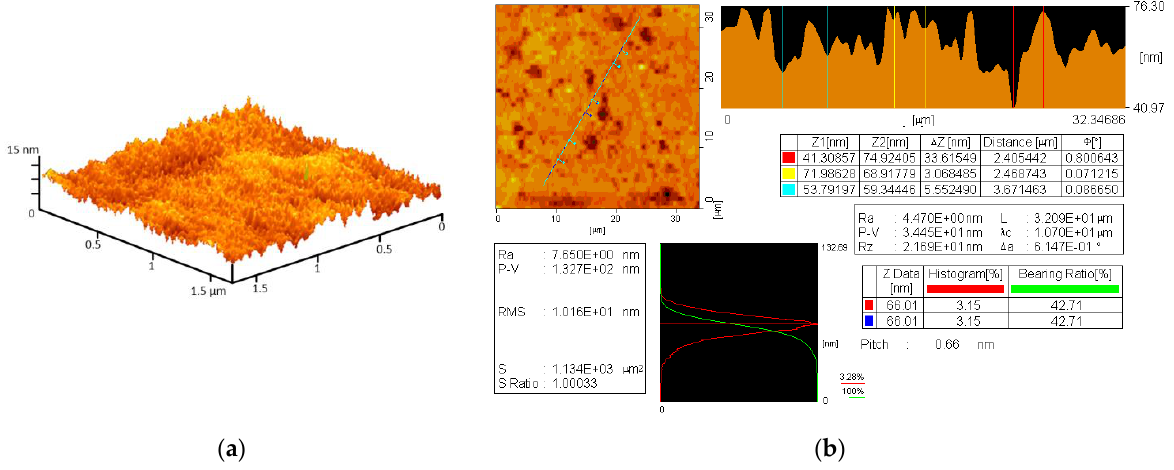
Figure 4. Reconstruction of nanocomposite surface with AFM: ( a ) 3D-reconstruction; ( b ) Example of results.